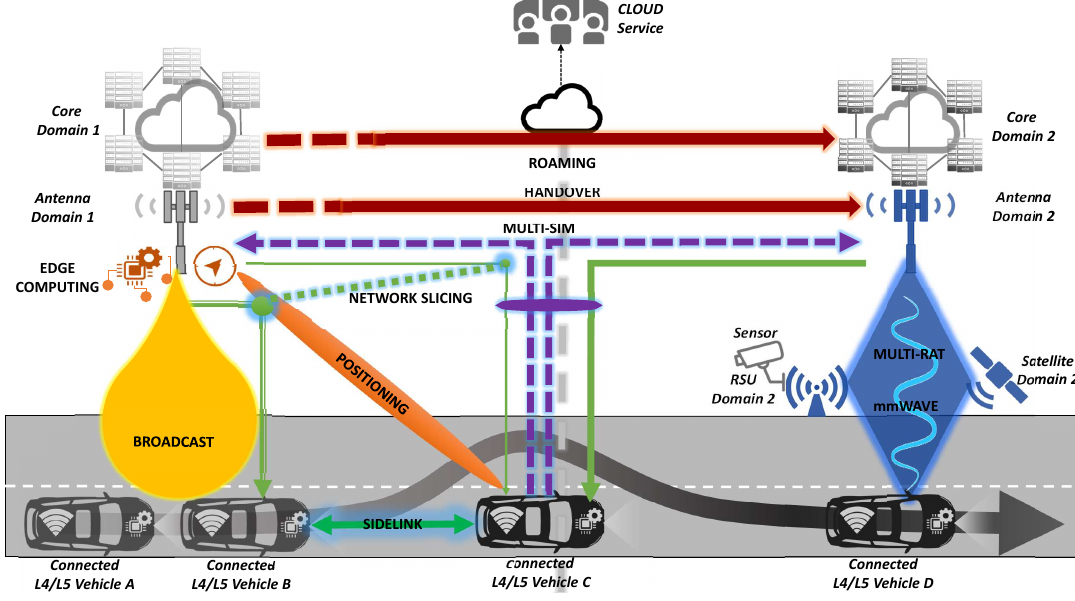
Figure 3. General scenario of the proposed